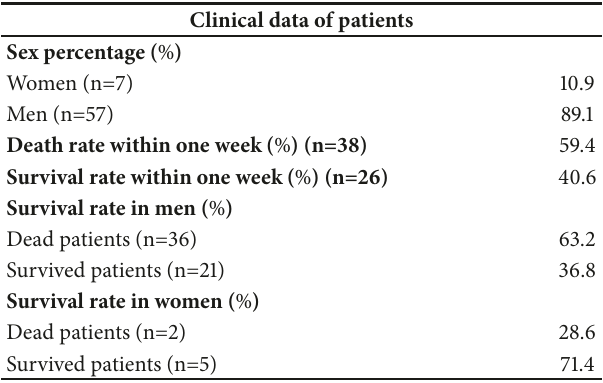
Table 1: Clinical data collected from medical records of patients with Severe Traumatic Brain Injury within one week in